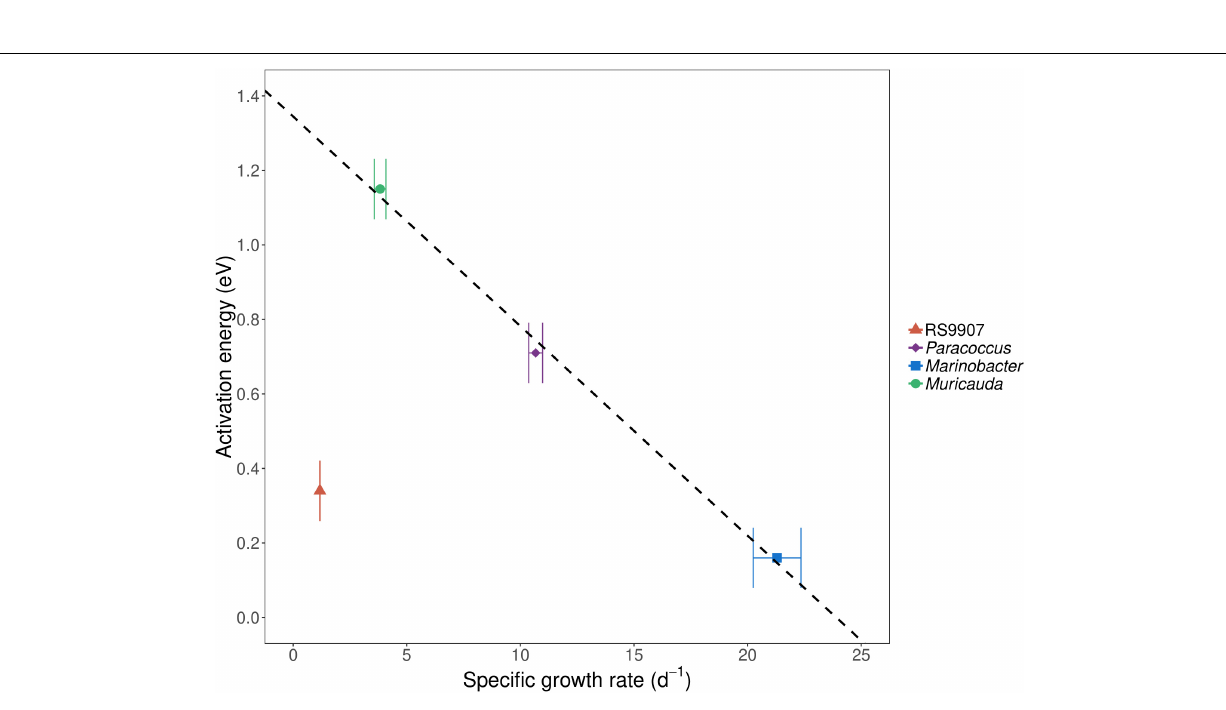
Frontiers in Microbiology |